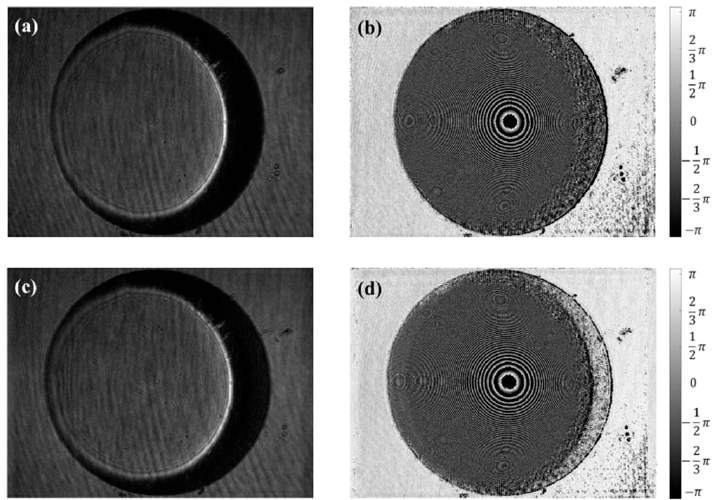
Figure 9. Between the direct-collected wave front ( θ = 20 ◦ , β = 0 ◦ ) and the wave front after employing the di ff raction calculation ( a ) amplitude image of unprocessed wave front. ( b ) phase image of unprocessed wave front. ( c ) amplitude image of processed wave front by algorithm. ( d ) phase image of processed wave front by algorithm .